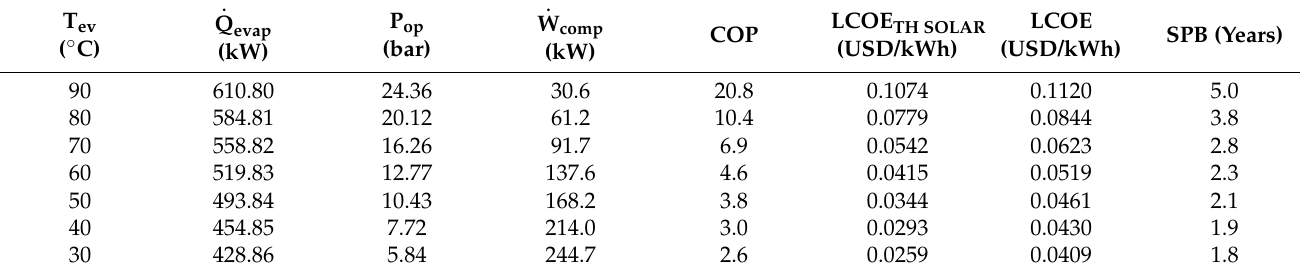
Table 4. Thermo-economic results of the heat pump (case study